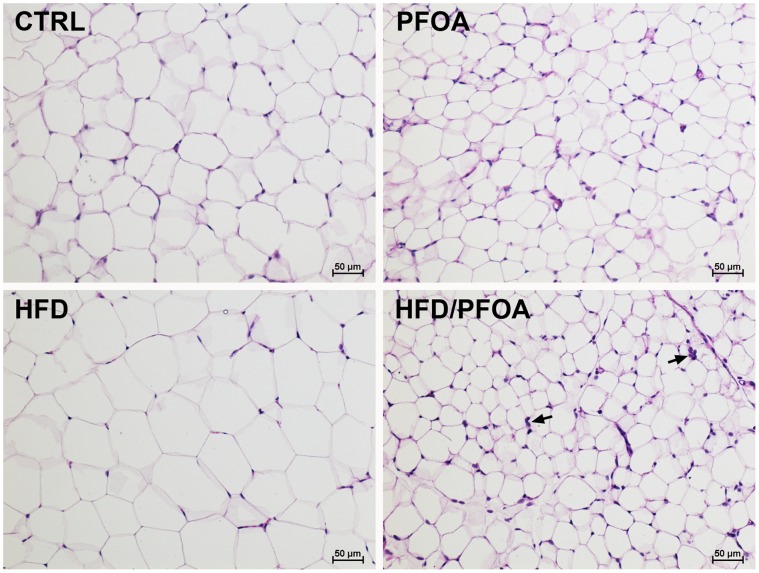
Histopathological alterations in the eWAT of mice fed HFD or/and PFOA.Adult mice were pair-fed a high-fat diet (HFD) or low fat control diet (CTRL) with or without perfluorooctanoic acid (PFOA) administration at 5 mg/kg/day for 3 weeks. H&E staining of Epididymal white adipose tissue (eWAT). Arrows: Inflammatory cell infiltration.